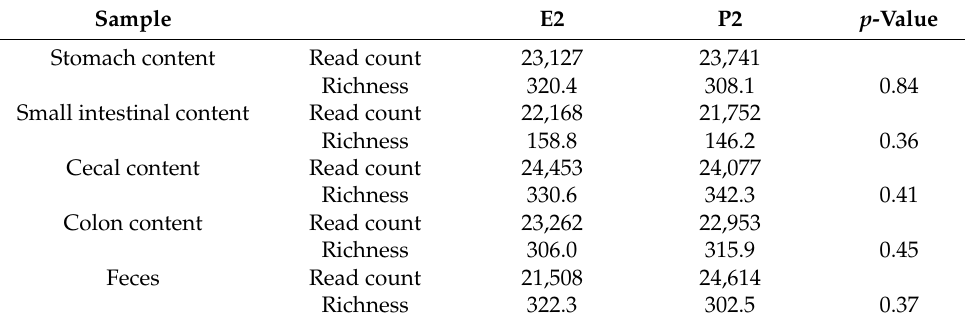
Figure 1. ( a ) α -diversity shown as richness in different intestinal regions of trial 1. The group fed with extruded feed is plotted on the left, the pellet-fed group on the right. Stars indicate significance between the respective gut regions of both groups. ( b ) β -diversity of trial 1 is shown as a multidimensional-scaling (MDS) plot. The scale indicates the distance between samples (d = 0.1 marks 10% difference). E = extruded diet, P = pelleted diet, S = stomach, SI = small intestine, CAE = cecum, COL = colon, FAE = feces. p -value summary: * p ≤ 0.05, *** p ≤ 0.001. Table 2. Read count and α -diversity (richness) in trial 2.